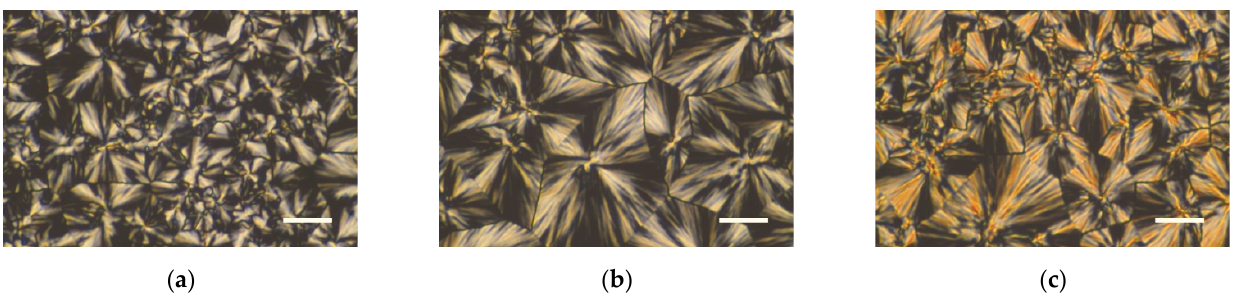
Figure 8. PLOM micrographs of ( a ) CUC2, ( b ) CUC3, and ( c ) CUC4 crystallized at 35 °C. Scale bar is 50 μ m.